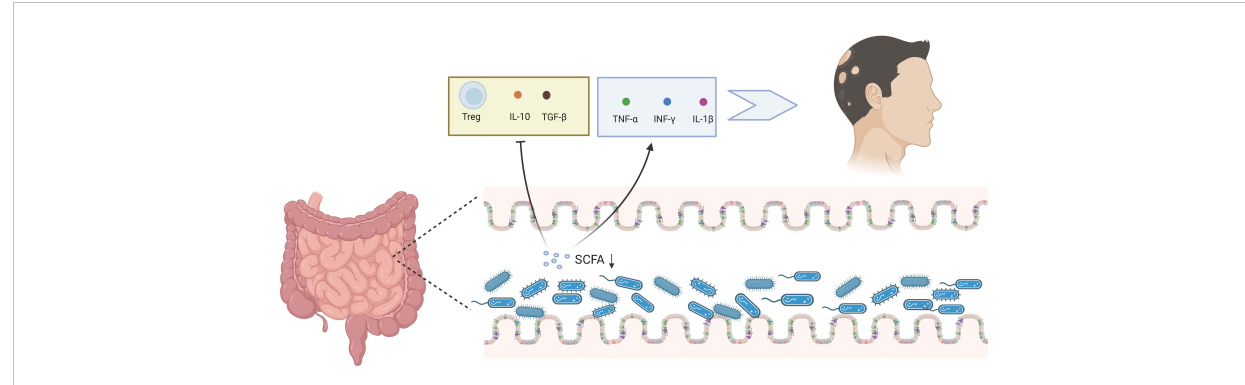
FIGURE 2 Gut microbiota and AA. The dysregulation of gut microbiota can reduce the SCFA, stimulating the release of TNF- a , IFN- g , and IL-1 b , while suppressing T